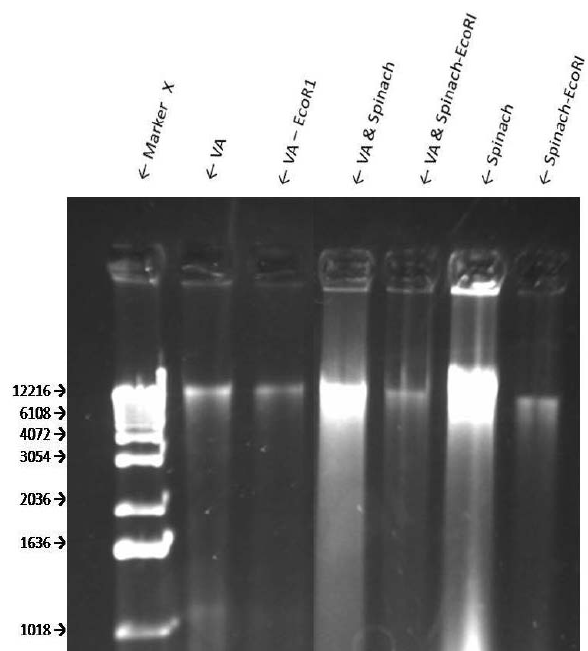
Figure 6: Sensitivity of VA Genomic DNA to Endoclease Digestion- Genomic DNA digestion of VA and S. oleracea with restriction enzyme EcoRI. Agarose gel electrophoresis of genomic DNA samples of VA and spinach were digested with restriction enzyme Eco RI. Eco RI cuts at recognition sequence G ↓